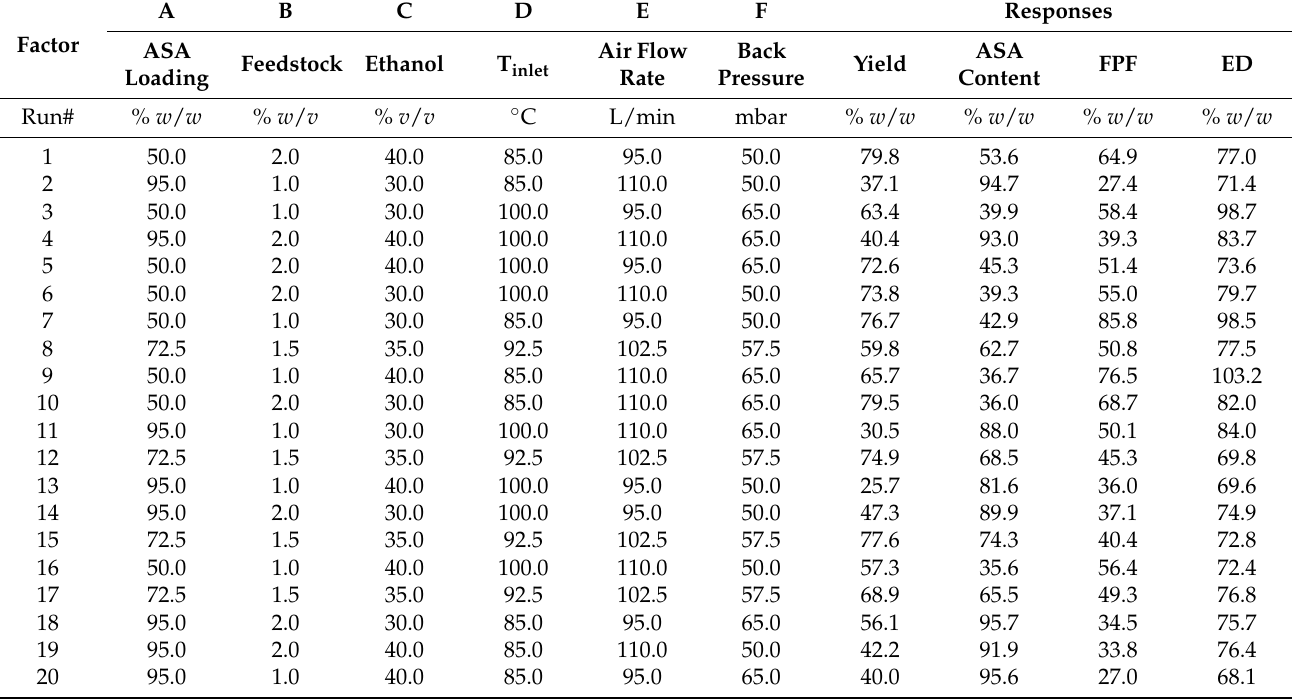
Table 2. Factors, levels, and response values of the 20 runs performed according to the 2 6 − 2 fractional factorial